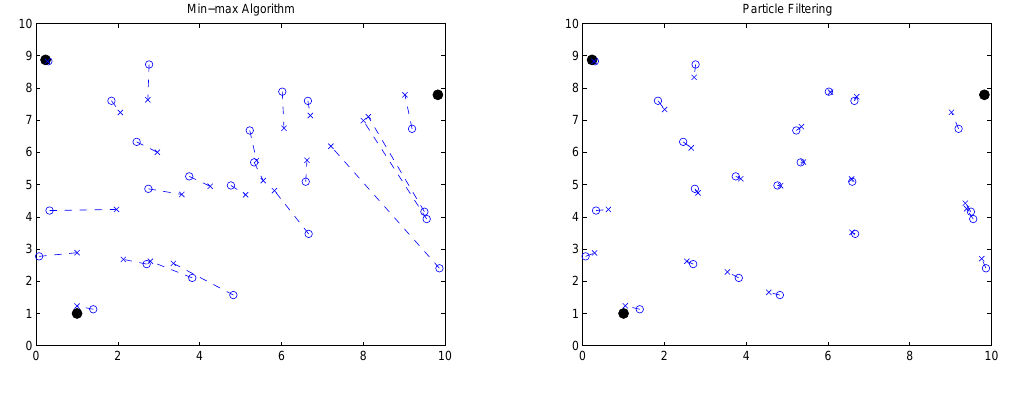
Figure 17. Using min-max and particle filtering for initial position